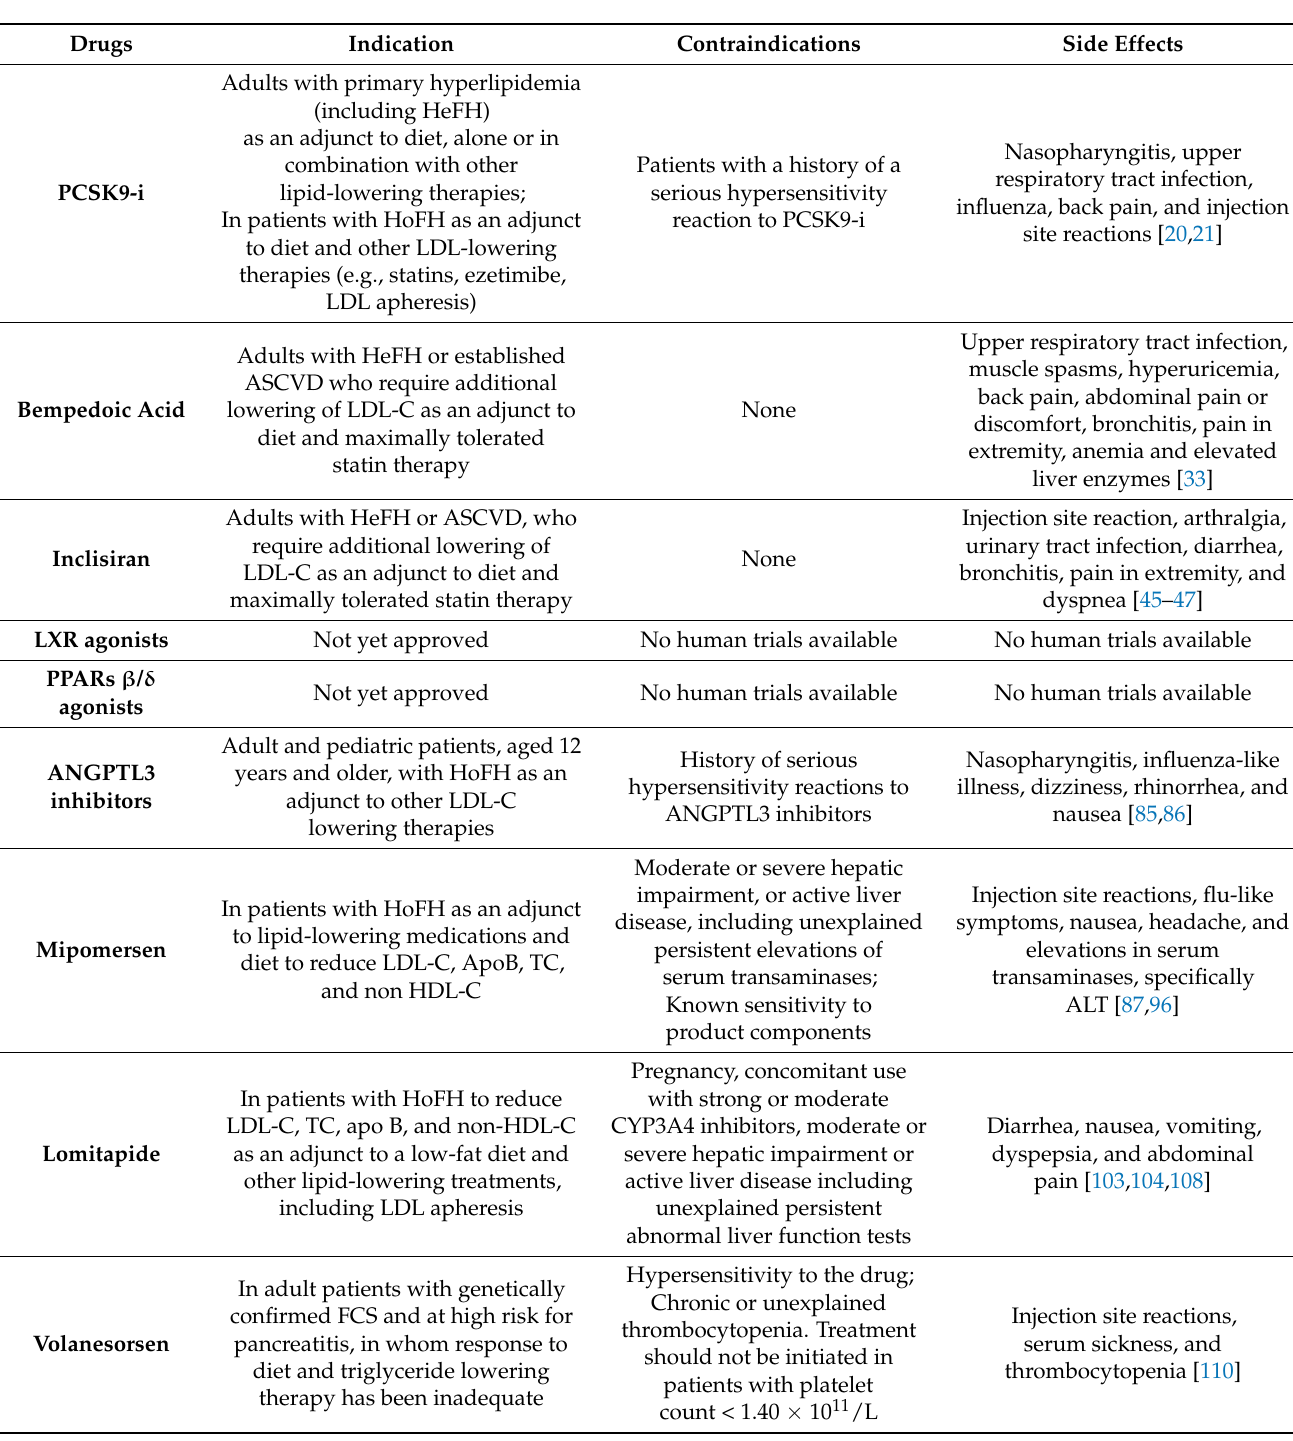
Table 2. Summary of indications, contraindications, and main side effects of the novel Lipid Lowering